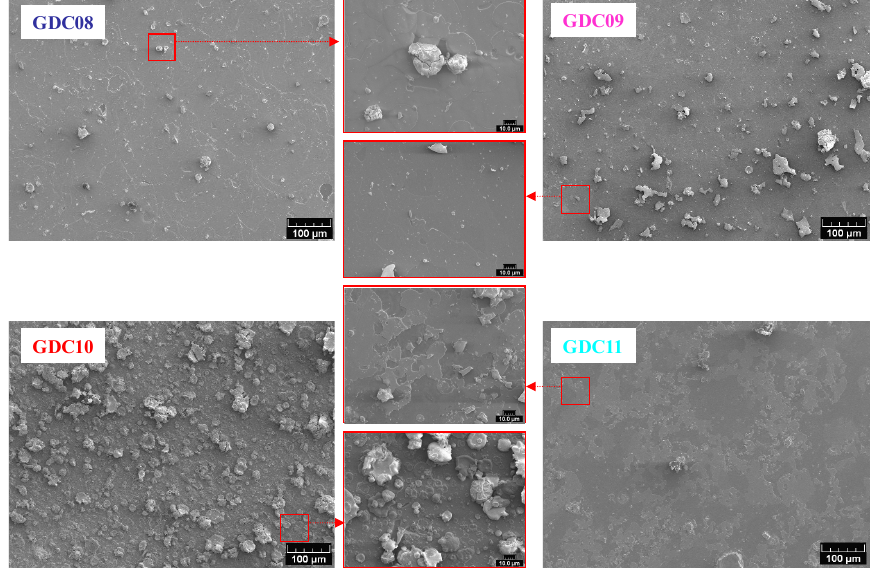
Figure 4. Top surface SEM micrographs of GDC coatings deposited on AISI 430 stainless steel substrates.